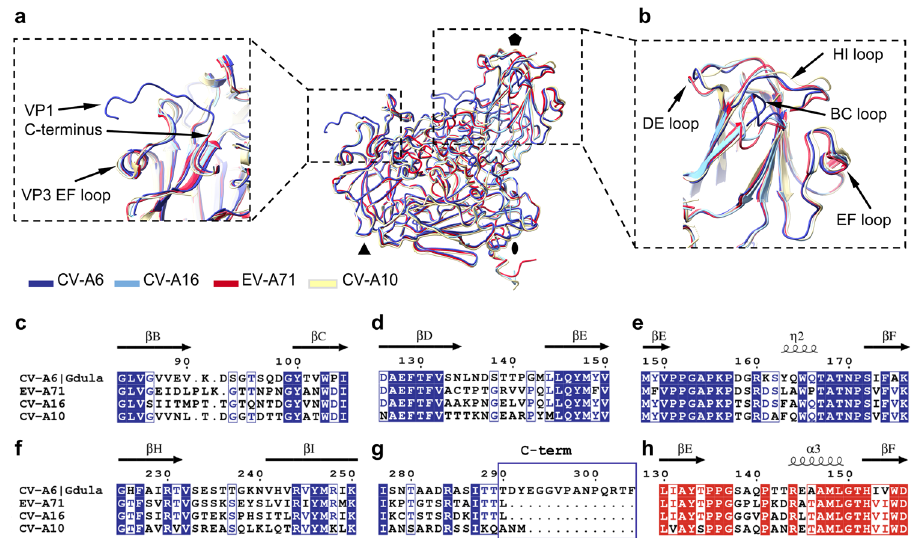
Fig. 4 Comparison of structures of capsid protomers from virions of CV-A6, CV-A16, EV-A71, and CV-A10. The proteins are shown in cartoon representation. a , b Major differences between viruses were found in VP1 C-termini and VP1 surface loops positioned near the fi vefold symmetry axis. a CV-A6 virion is unique in containing an exposed C-terminus of VP1, which covers the EF loop of VP3. b Detail of the differences in BC and HI surface loops of VP1. c – h Sequence alignment of VP1 ( c – g , blue) and VP3 ( h , red) from CV-A6, EV-A71, CV-A16, and CV-A10 showing the amino acid sequence variation of surface-exposed regions. The secondary structure elements of CV-A6 are indicated at the top.